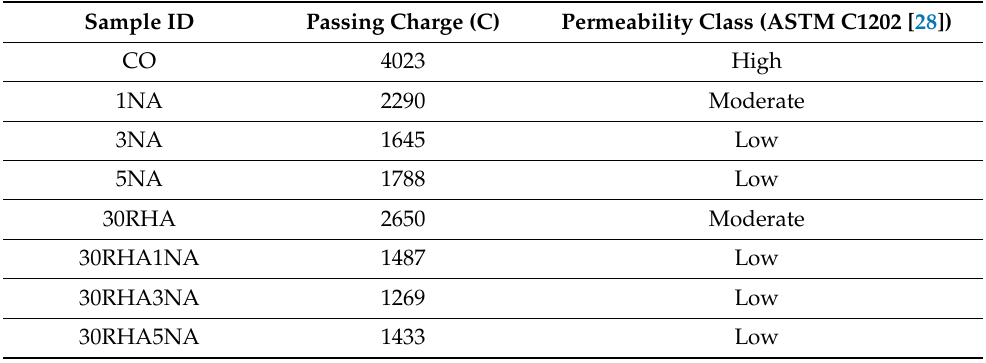
Table 6. Results of rapid chloride ion permeability test (RCPT) for SC